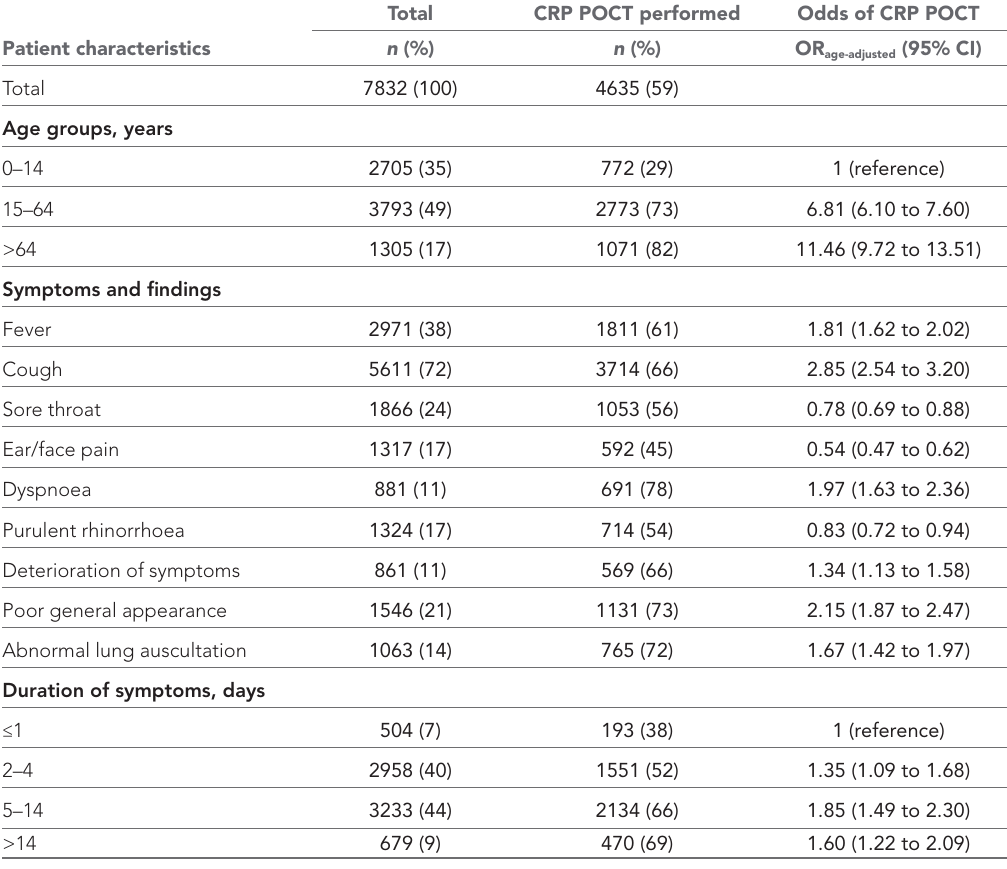
Table 2 C- reactive protein (CRP) tests for patients with acute respiratory tract infections in Danish general practice